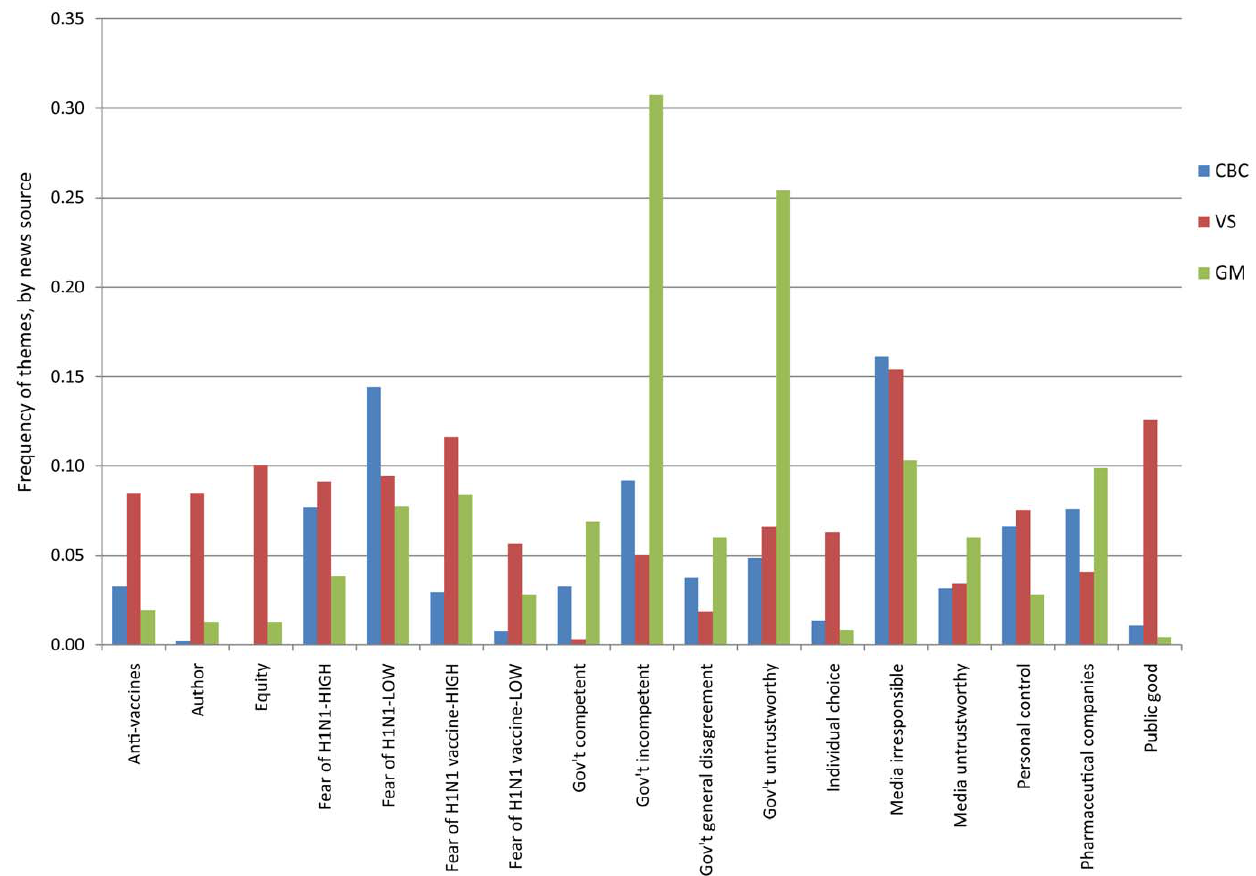
Figure 2.Themes by news source. Frequency of themes within each news source; includes themes associated with at least 5% of comments from at least one news source.